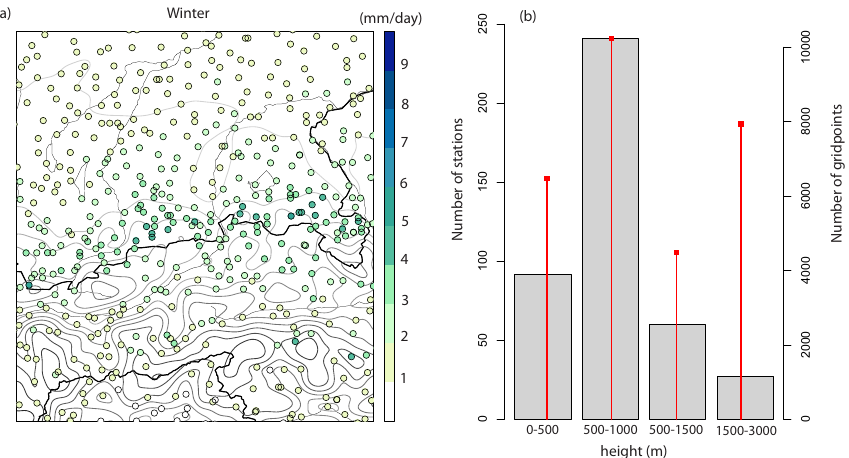
Figure 2. (a) Map of the study domain, a section of the Alpine ridge (see also Fig. 1). The topography is indicated by grey-shaded contour lines (spacing 250m). The station network is indicated by colored circles representing long-term mean winter (DJF) precipitation in mm/day. The thick black line represents the national borders between Germany (top), Austria (middle) and Italy (bottom). (b) Bar plot of the distri- bution with height ( x axis, mm.s.l.) of the number of stations (grey, left y axis) and the number of grid points in a 1km DEM (red, right y